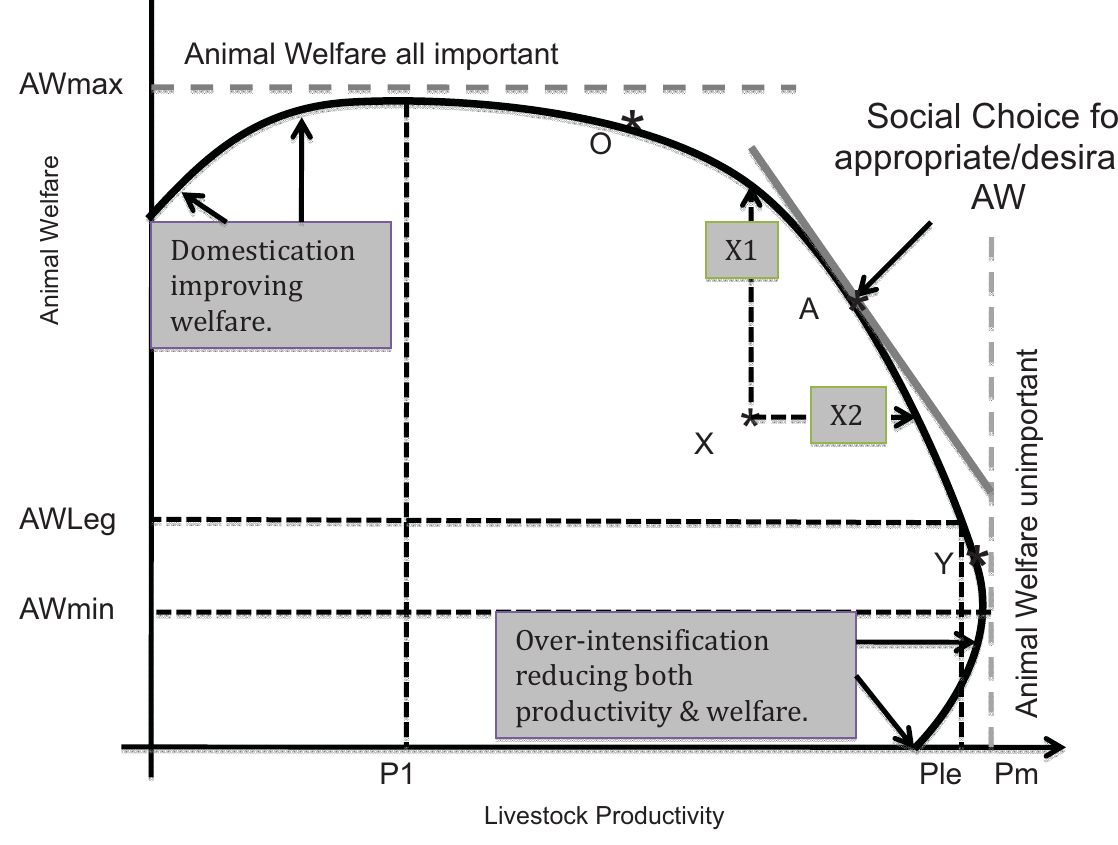
Figure 2. Possibilities for improving animal welfare (following